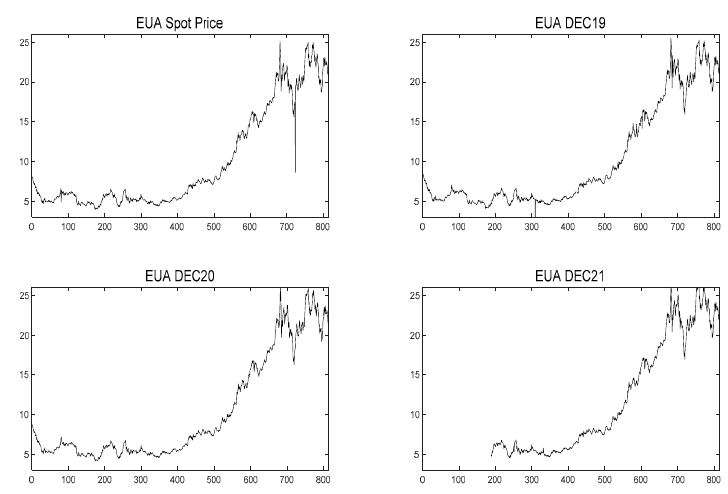
Figure 4. The original carbon price under the European Union emissions trading scheme (EU ETS).